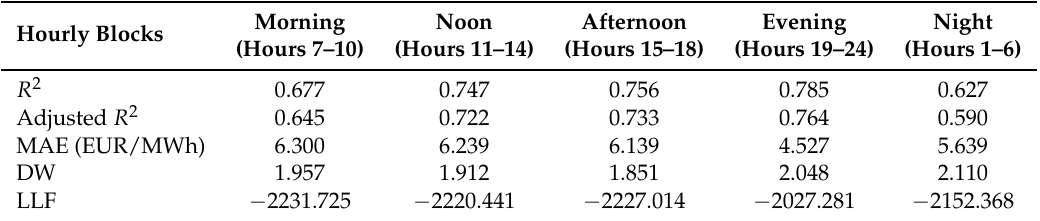
Table 10. Goodness of fit, for morning, noon and afternoon hourly blocks weekend, excluding renewable energies wind and